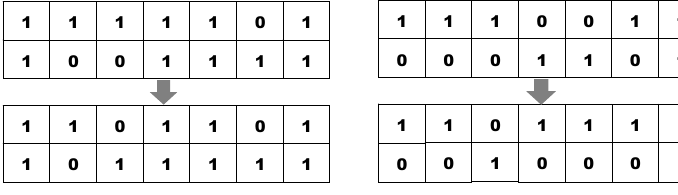
Figure 4. Applying 2-point crossover on sample chromosomes.